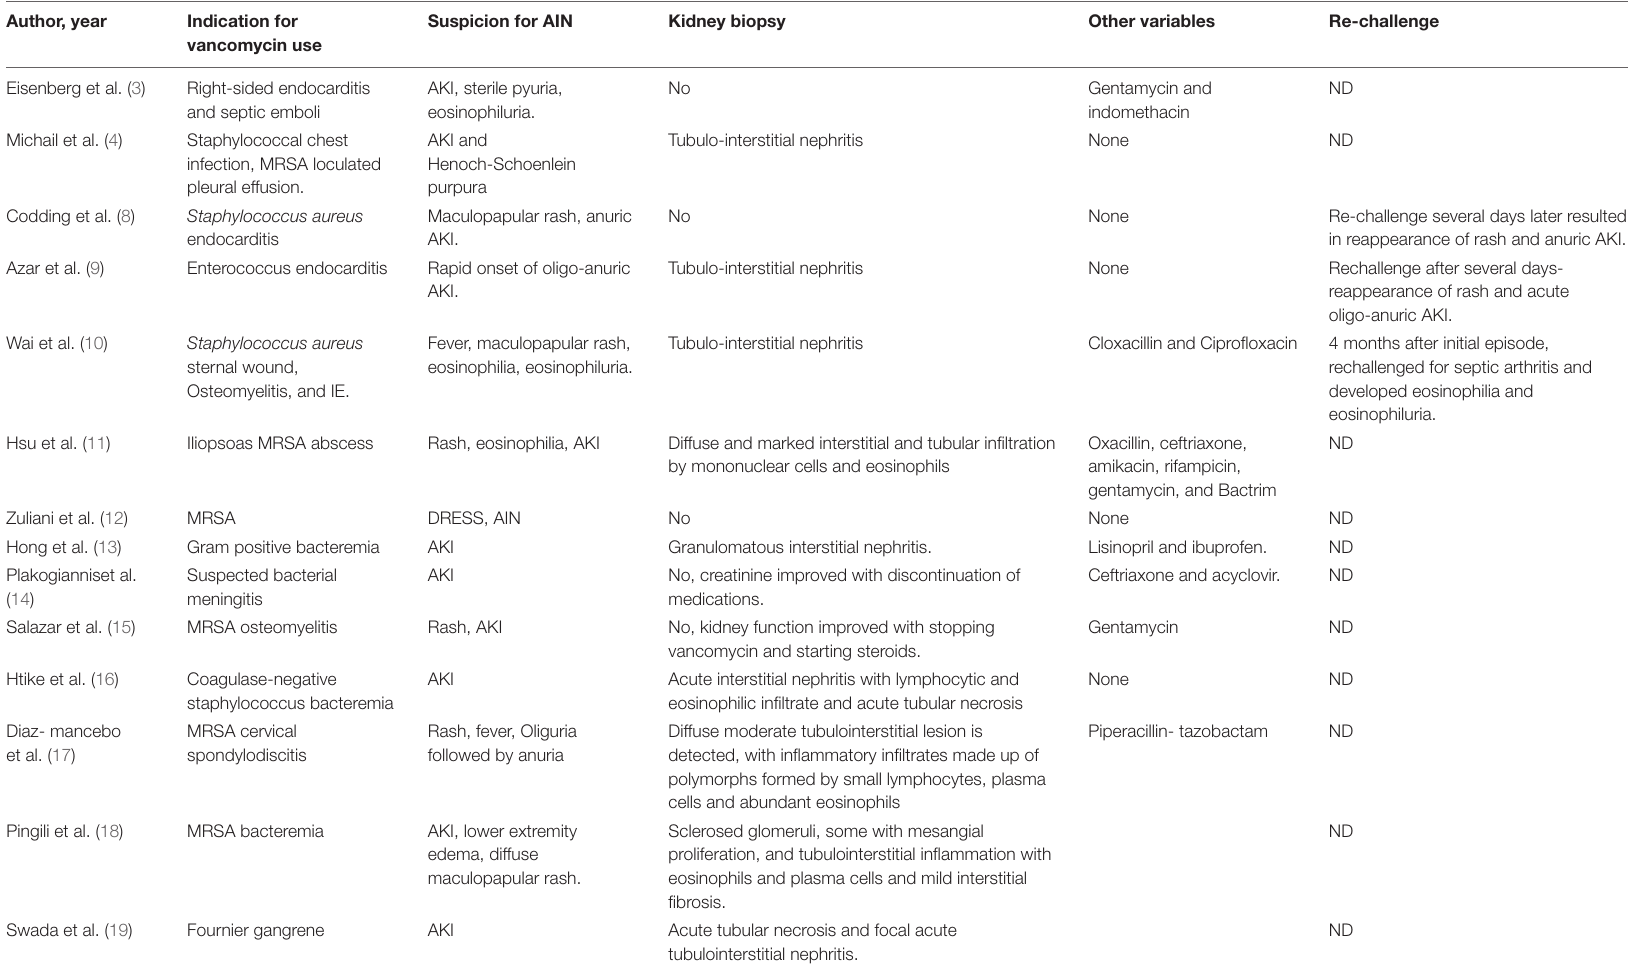
TABLE 2 | A Literature review of vancomycin-associated tubulointerstitial